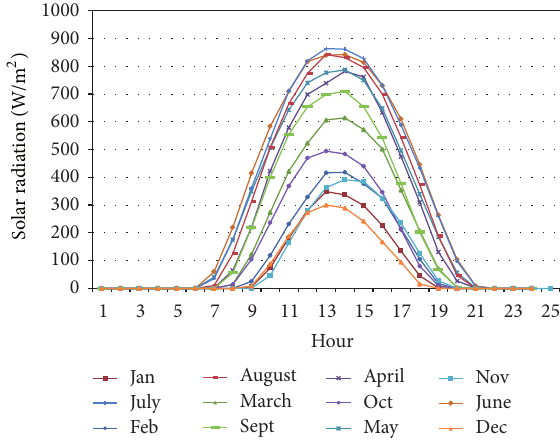
Figure 4: Hourly average of solar radiation data for 12 months of the